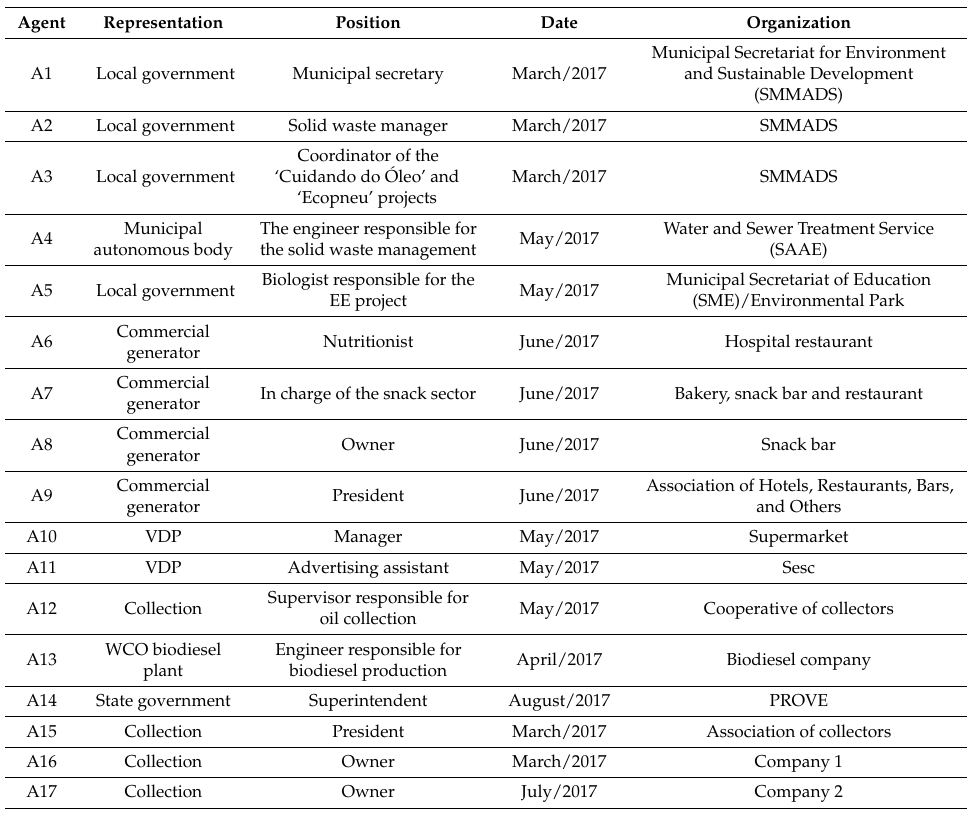
Table 2. Agents (A) interviewed from the WCO reverse supply chain in RMPF. Source: Created by the